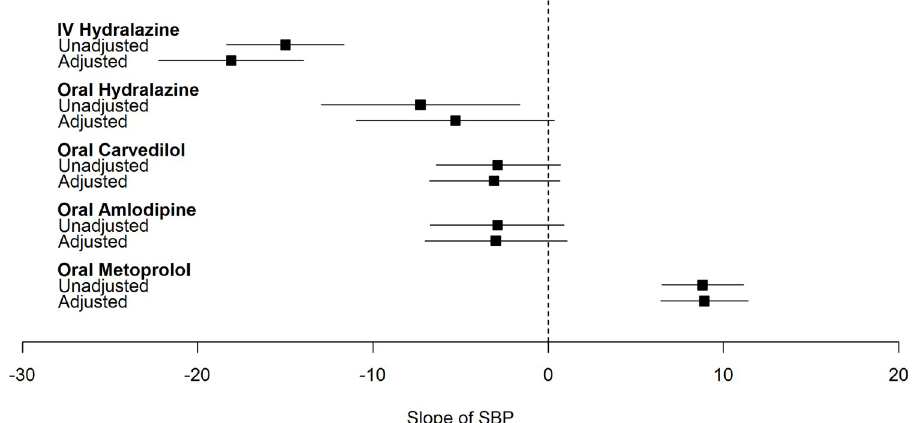
Fig 3. Plot of effect estimate ( β [95%CI]) of common antihypertensives on slope of systolic blood pressure within 6 hours of severe inpatient hypertension development. Adjusted for age, sex, race, ethnicity, ward, comorbidities (congestive heart failure, cardiac arrythmia, valvular disease, pulmonary circulation disorder, peripheral vascular disease, hypertension, paralysis, other neurological disorders, chronic pulmonary disease, diabetes, hypothyroidism, renal failure, liver disease, peptic ulcer disease excluding bleeding, AIDS/HIV, lymphoma, cancer, rheumatoid arthritis/collagen disorder, coagulopathy, obesity, weight loss, fluid and electrolyte disorders, blood loss anemia, deficiency anemia, alcohol abuse, drug abuse, psychosis, depression), baseline laboratory values (sodium, potassium, chloride, bicarbonate, BUN, eGFR, WBCC, platelet count, hemoglobin, hematocrit), NSAID use 0–6 hours before time of severe inpatient HTN, crystalloid use 0–6 hours before time of severe inpatient HTN, steroid use 0–6 hours before time of severe inpatient HTN, narcotic use 0–6 hours before time of severe inpatient HTN, sedative use 0–6 hours before time of severe inpatient HTN, maximum MAP before time of severe inpatient HTN development, minimum MAP before time of severe inpatient HTN development, coefficient of variation of MAP before time of severe inpatient HTN development.